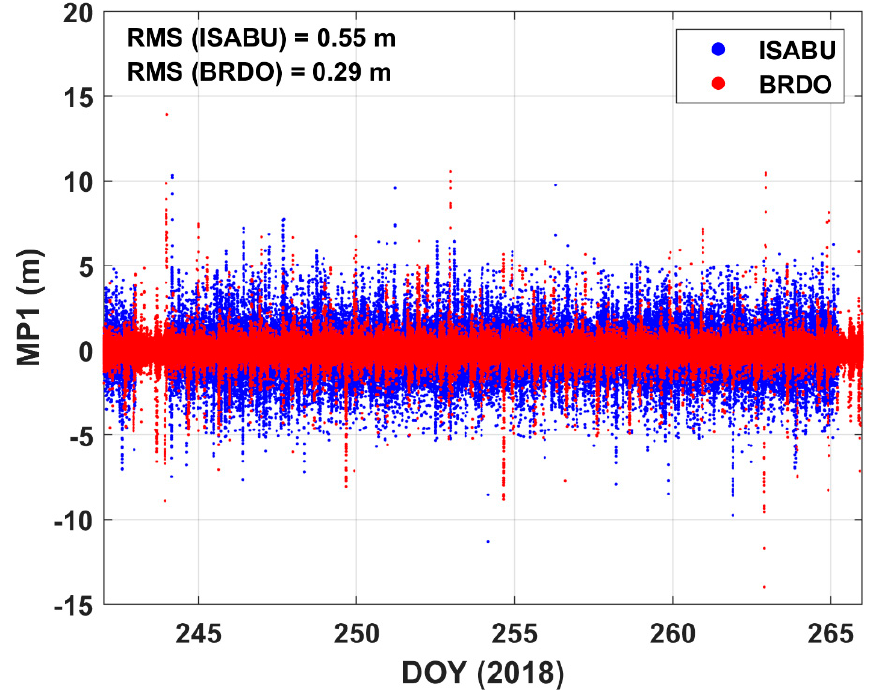
Figure 5. Time series of GPS L1 code multipath (MP1) errors. The blue dots and red dots represent MP1 at the vessel ISABU and MP1 at the ground BRDO station, respectively.